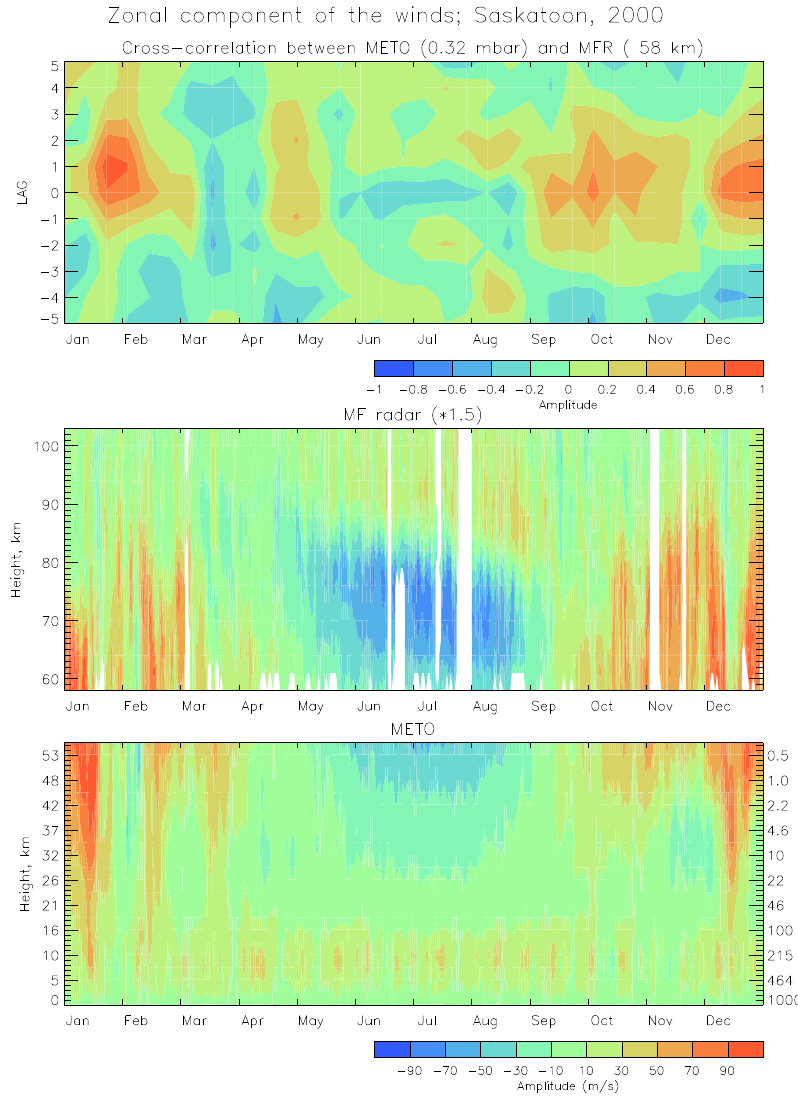
Fig. 3. The contour plots of zonal winds from MetO (the bottom panel) and MF radar (the middle panel) for Saskatoon during 2000. The cross-correlations calculated between the MetO winds at 0.32mbar and MF radar winds measured at 58km are shown on the upper